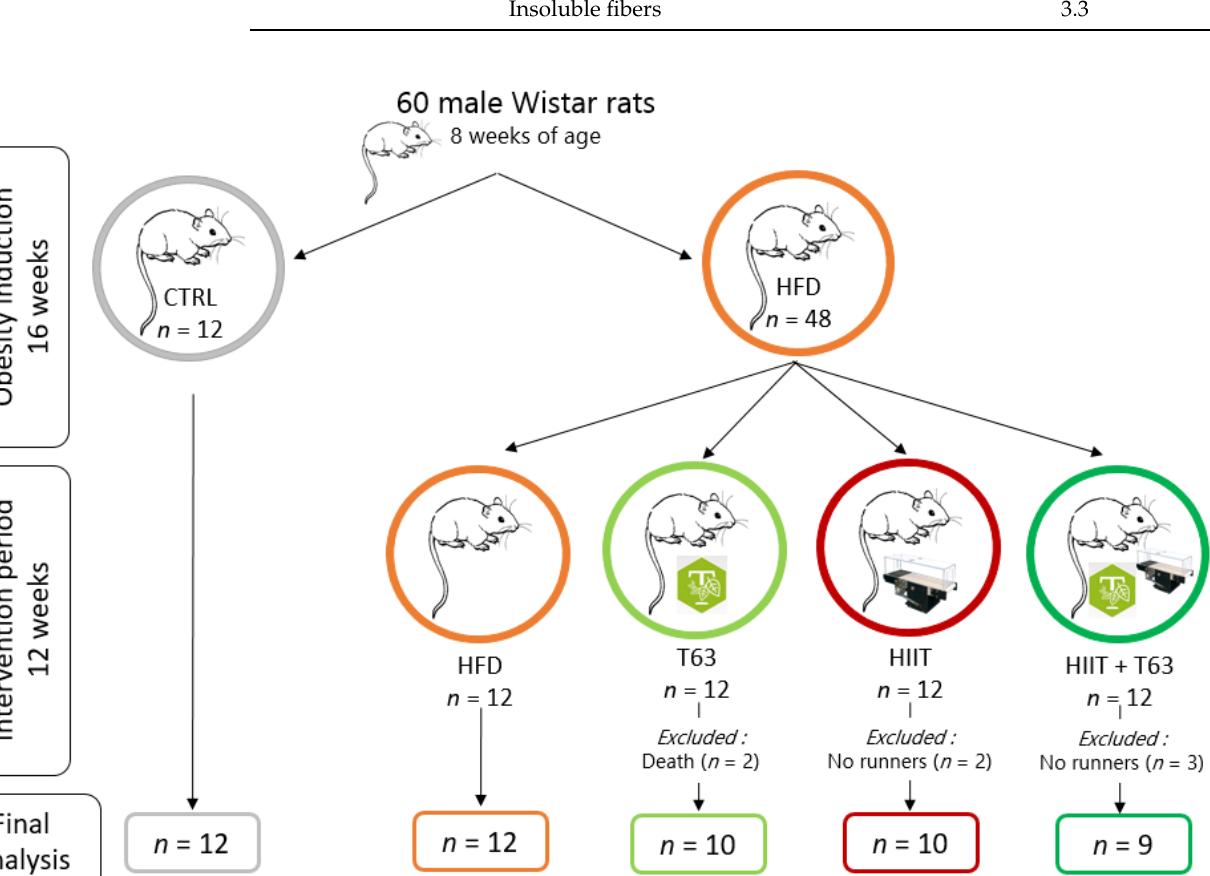
Figure 1. Study design. Rats were randomized in two groups: control (CTRL; n = 12) and High-Fat Diet (HFD; n = 48) for 16 weeks (obesity induction). Then, the HFD group was divided in four groups ( n = 12/group) matched for weight, fat mass and fasting blood glucose: HFD, TOTUM-63 (T63), High-Intensity Interval Training (HIIT), and HIIT + T63 (intervention period for 12 weeks). In the HIIT and HIIT + T63 groups, “no runner” rats were excluded from the study. Two rats from the T63 group died during glucose gavage due to intubation mishandling. Finally, 41 rats were included in the analysis (HFD: n = 12; T63: n = 10; HIIT: n = 10 and HIIT + T63: n = 9).